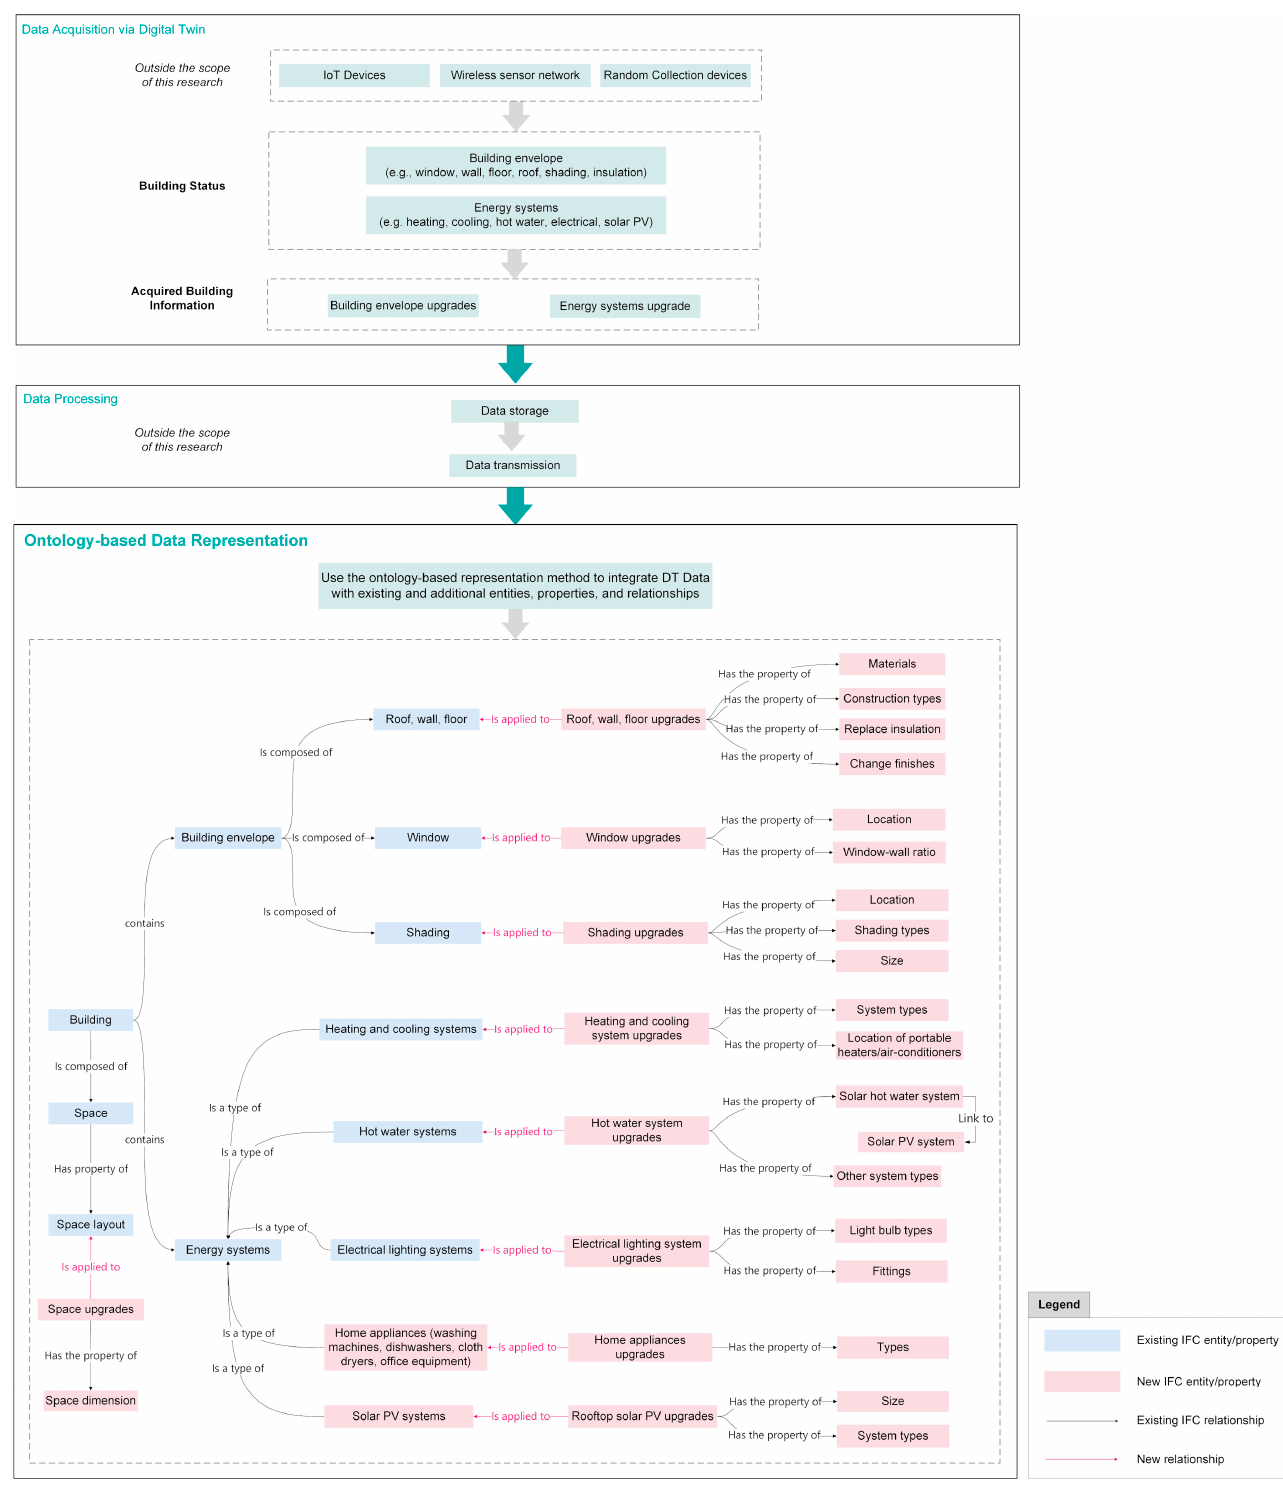
Figure 19. Illustration of DT data integrated into extension using the ontology-based representation method to represent key decision variables at operational stage.